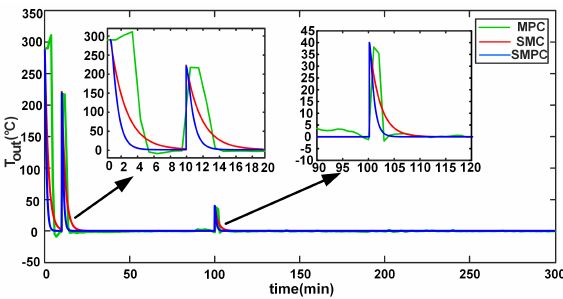
Fig. 9. Molten salt mass flow